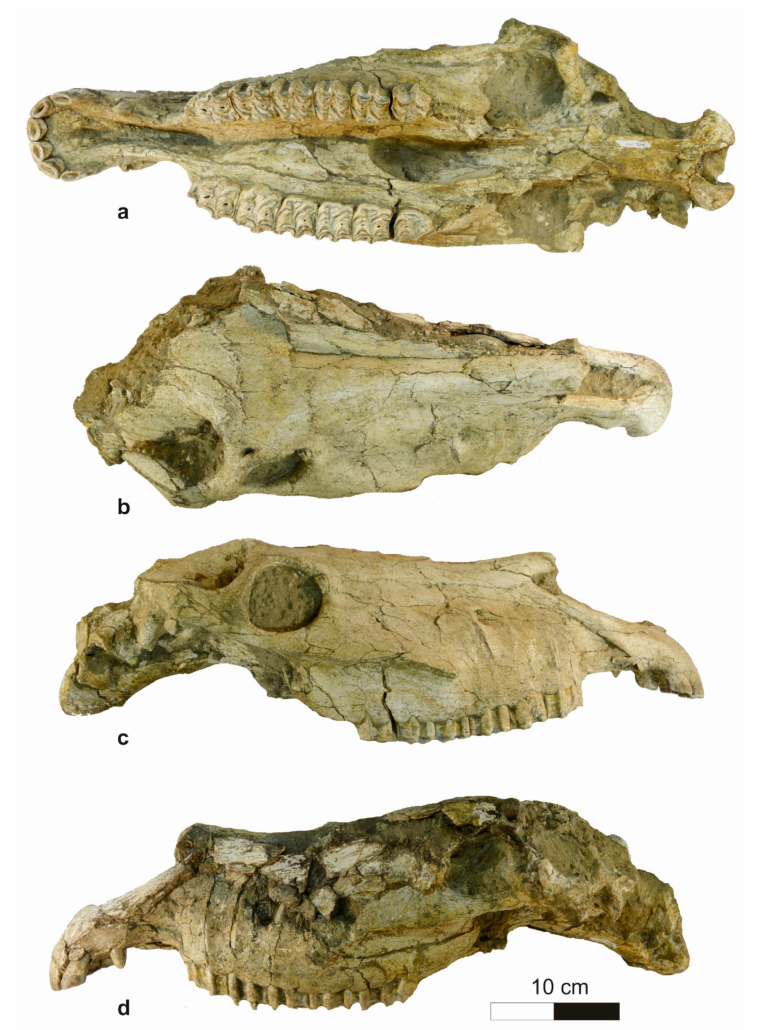
Figure 2. Equus apolloniensis , APL-148; ( a – d ) cranium, ( a ) ventral view, ( b ) dorsal view, ( c ) right lateral view, and ( d ) left lateral